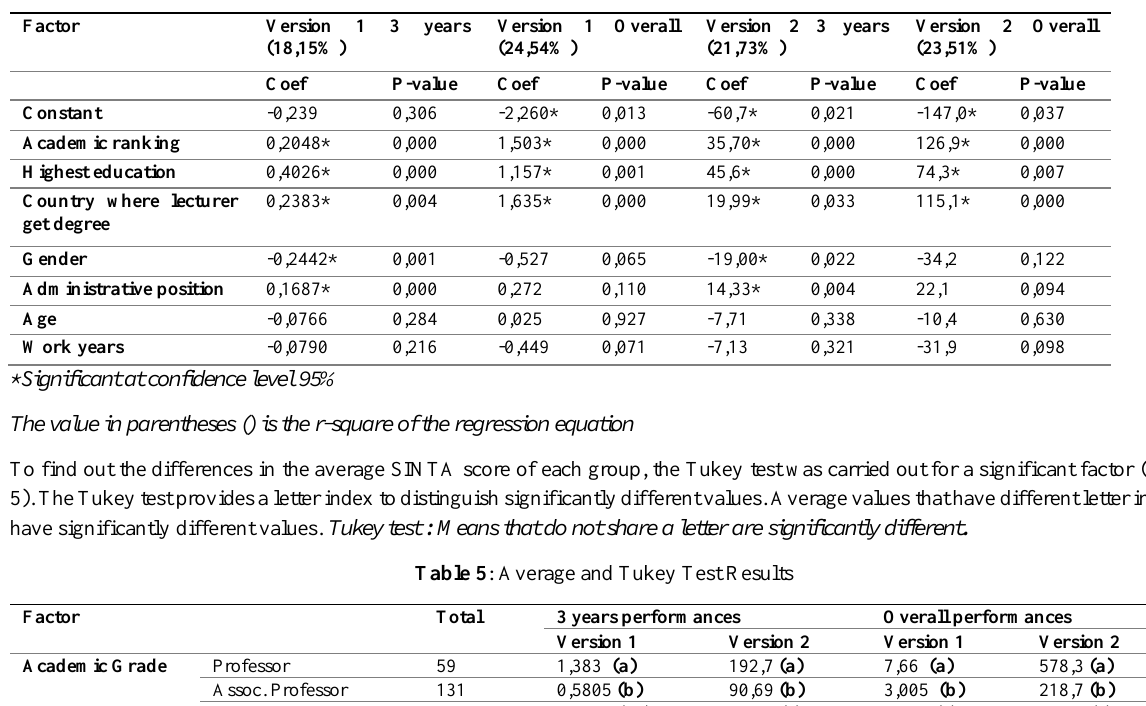
Table 4 : Results of Regression Test